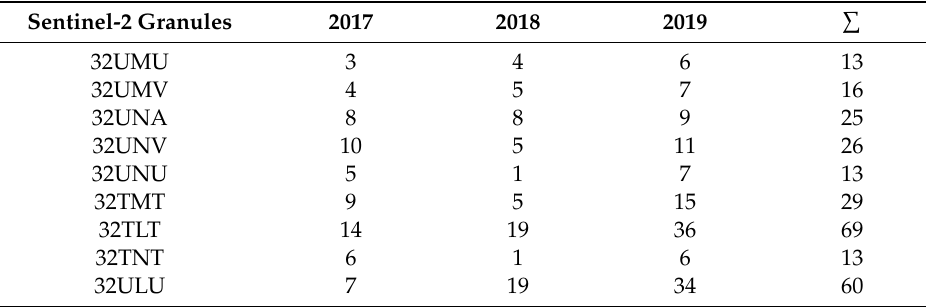
Table 1. Number of Sentinel-2 granules used to calculate a vegetation